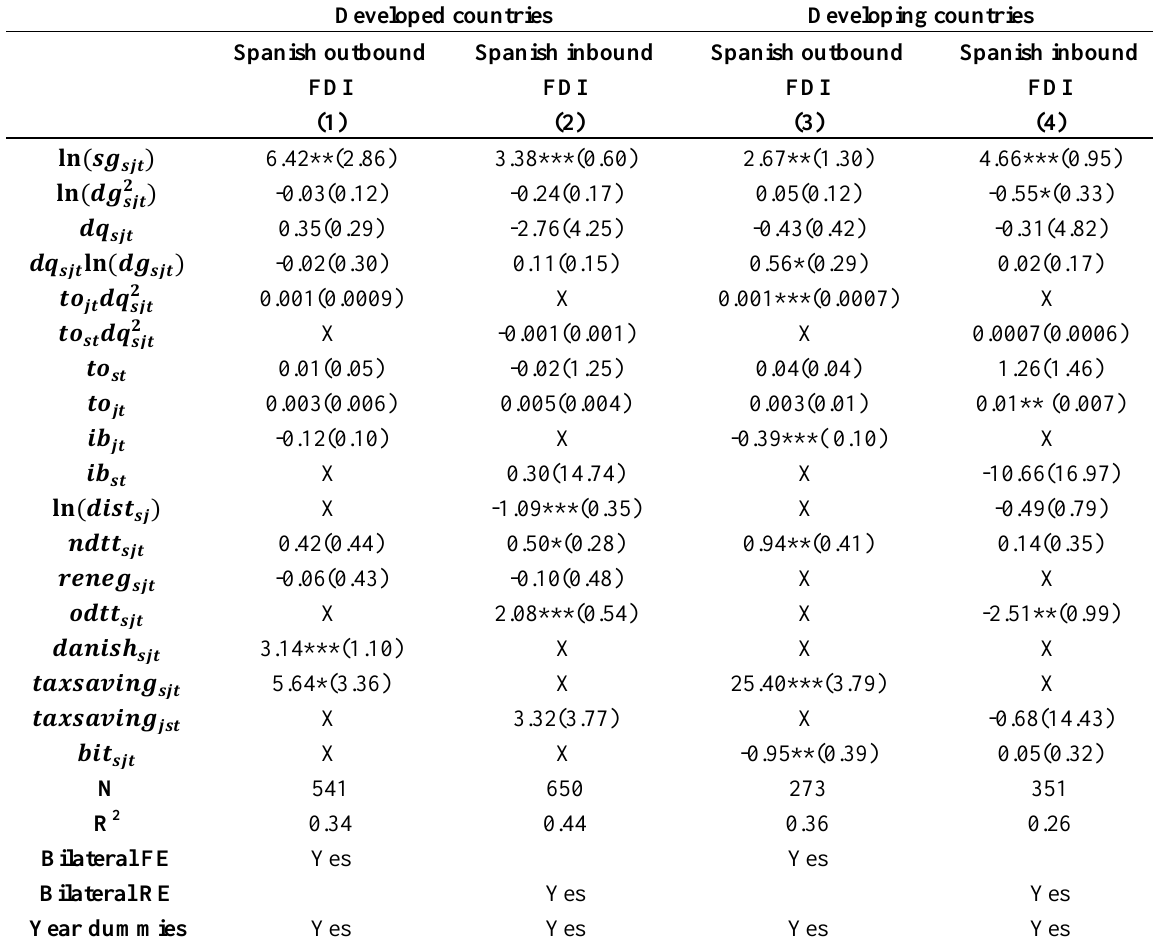
Table 7 : Effect of DTTs and the Territorial Tax System on Spanish inbound and outbound FDI: Types of DTTs. Developed and developing countries Developed countries Developing countries Spanish